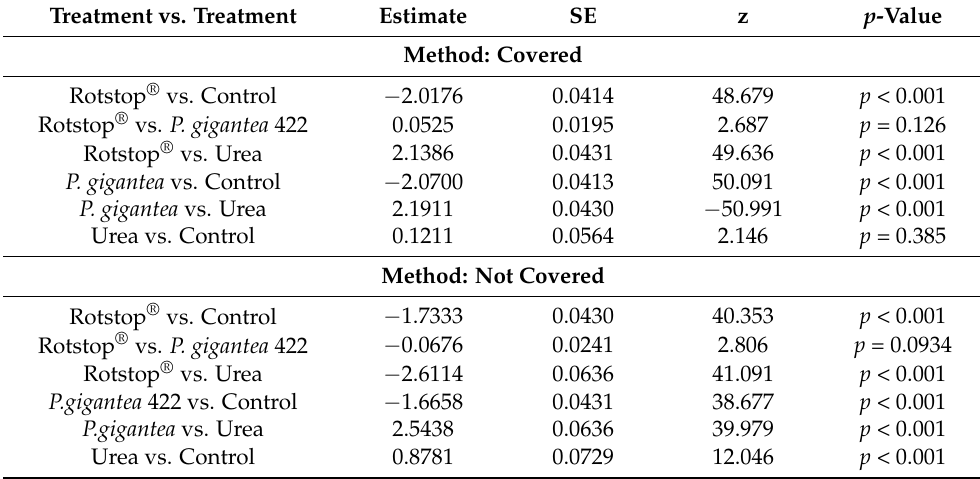
Table A2. Output of statistical tests reflecting relative P. gigantea colonized area, colonies per cm 2 . Relative colonized area, Family = Poisson, Factors = Method +